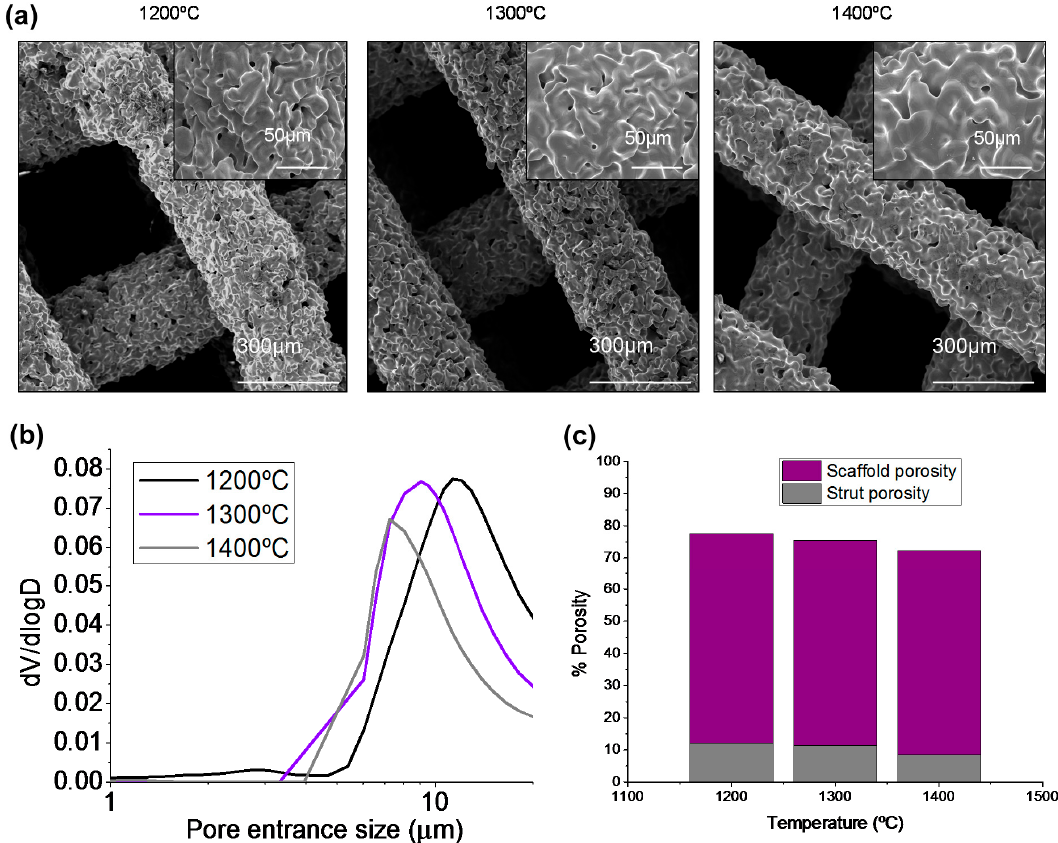
Figure 5. ( a ) Representative SEM micrographs of scaffolds sintered at different temperatures. ( b ) Pore entrance size distribution and ( c ) Scaffold and strut porosity at three different sintering temperatures. Table 2. Characterization of the Ti scaffolds sintered at 1200 °C, 1300 °C and 1400 °C: strut diameter after sintering, percentage of scaffold shrinkage, surface roughness and porosity. Samples with different symbols (*, # , $ ) present statistically significant differences ( p < 0.05).